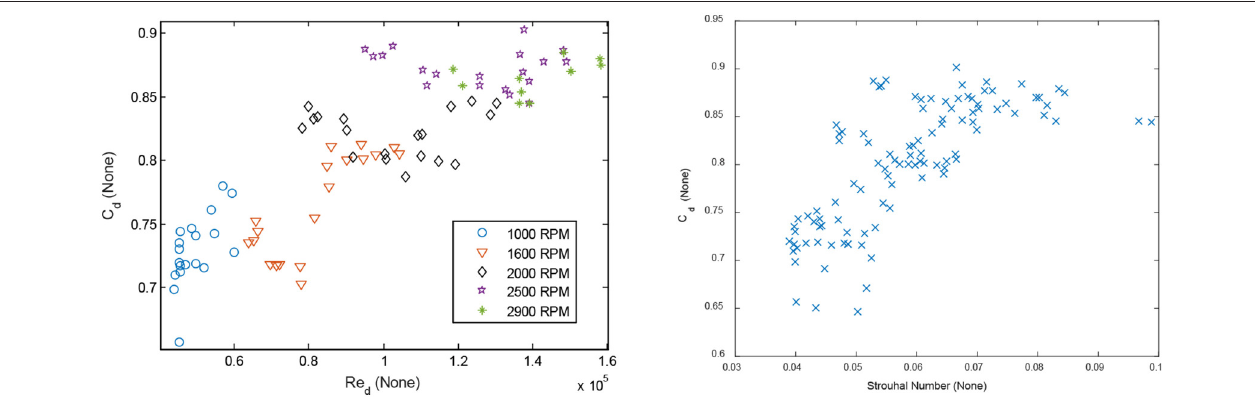
FIGURE 7 | Left: Engine data showed a large variation in C d and suggests that Re d and C d are unrelated (though correlated) or that other additional variables determine C d . The lines are best fit lines at each RPM. The non-pulsating C d was calculated by using a mathematical function from the (Fluid Meters, 1971b) ASME report (Brahma, 2011). Right: The variation of C d is not explained by the Strouhal number